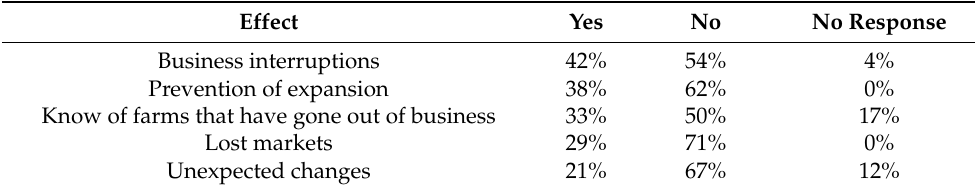
Table 4. Business interruptions, prevention of business expansion, farms that have gone out of business, and markets lost because of regulations ( n = 24).